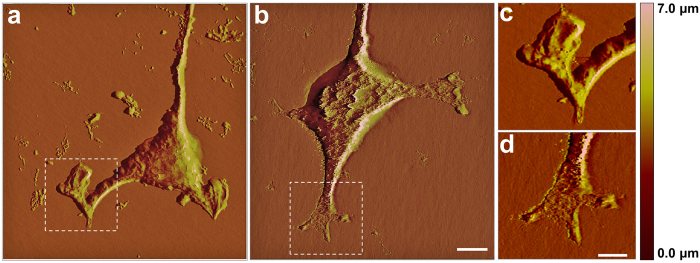
Decreased cell process numbers in the HMF.(a–d) Representative atomic force microscope scanning photos show cell protrusion structure of the cells exposed to the HMF (a) and GMF (b) after 48 h incubation. An enlarged view of the cell front protrusions of the cells incubated in the HMF (c) or GMF (d). The cell front protrusions of the HMF-exposed cells appeared retracted (c), whereas those of the GMF control cells were out-stretched (d). (e–j) The number of cell processes (Ncp) was determined at 12 h intervals when cells were maintained under DMEM with 10% FBS. (e) A representative image of the HMF-exposed cells fixed at 24 h. The arrows indicate cell types with different CP numbers (Ncp). Blue, Ncp = 0; Green, Ncp = 1; Yellow, Ncp = 2; Red, Ncp ≥ 3. (f) The distribution of cell types with different Ncp in the HMF and GMF conditions from 12 h to 48 h. The distributions of Ncp were different between the HMF and GMF groups at 24, 36 and 48 h; specifically, fewer multiple-process cells (Ncp ≥ 3) were counted in the HMF. Data from three independent experiments, are shown as mean ± s.e.m. The P values were calculated using a Chi-square test. ****P < 0.0001. Representative images of Ncp cell types were shown as: Ncp = 0 (g), Ncp = 1 (h), Ncp = 2 (i) and Ncp ≥ 3 (j).